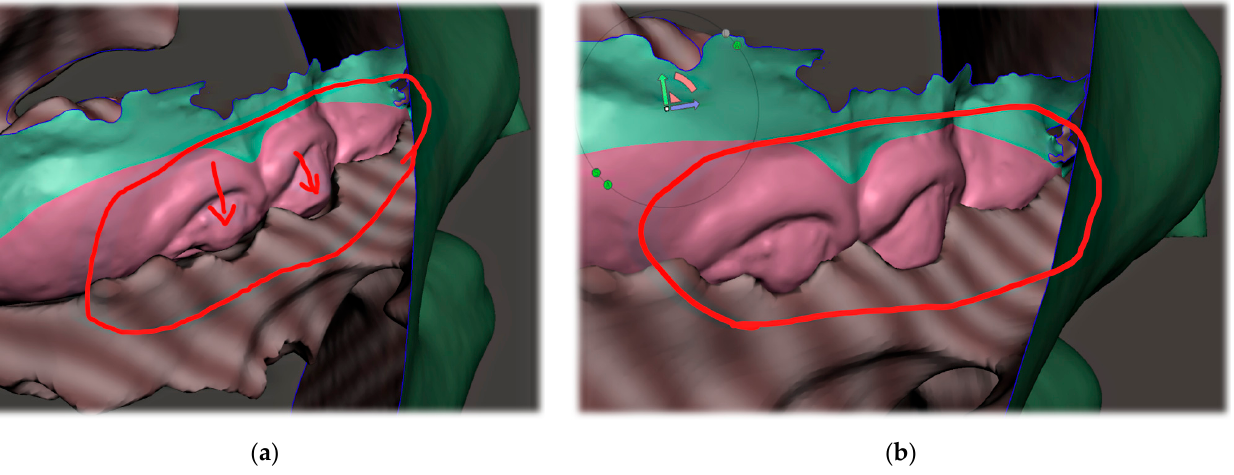
Figure 6. The alignment of the intraoral scan with segmented CT: ( a ) automatized alignment error found; ( b ) alignment of intraoral scan of the upper arch was corrected in Meshmixer™ (Autodesk ® , Inc., San Rafael, CA, USA).